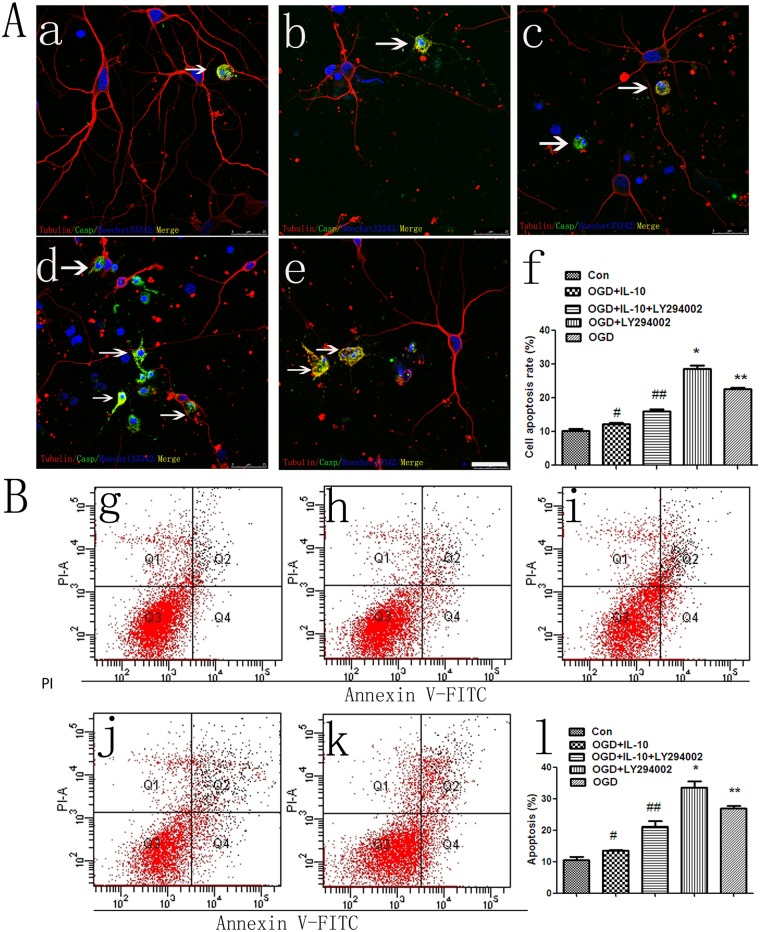
IL-10 reduces the neuronal apoptosis in OGD-induced injury model.
(A) Caspase-3 was performed to detect the cell apoptosis, showing apoptotic cell (green, arrows). The neurons were stained with class III-β-Tubulin (red). The apoptotic neurons were labeled yellow. (a) Normal control group. (b) OGD + IL-10 (20ng/ml) group. (c) OGD + IL-10 (20ng/ml) + LY294002 (20μM) group. (d) OGD+LY294002 (20μM) group. (e) OGD group. (f) **p<0.01 vs control group, #p<0.01 vs OGD group, ##p<0.05 vs OGD+IL-10 group,*p<0.01 vs OGD group. Scale bar, 25μm. (B) After 24h, assay of apoptosis by flow cytometry. The signals from apoptosis of neurons were localized in the four quadrant except Q3 of the resulting dot-plot graph. (g) Normal control group. (h) OGD + IL-10 (20ng/ml) group. (i) OGD + IL-10 (20ng/ml) + LY294002 (20μM) group. (j) OGD+LY294002 (20μM) group. (k) OGD group. (l) **p<0.01 vs Normal control group,# p<0.01 vs OGD group, *p<0.01 vs OGD group.